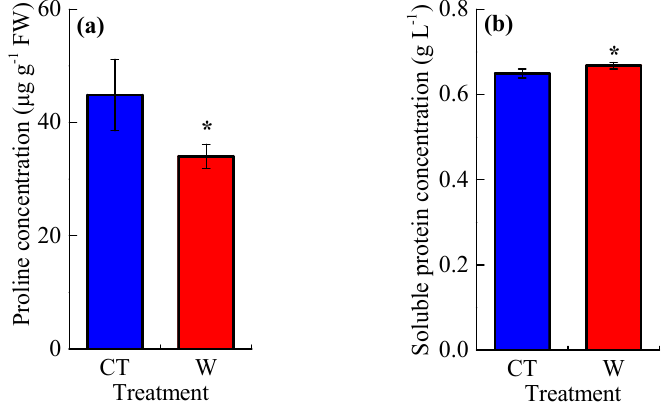
Figure 3. The concentrations of ( a ) proline and ( b ) soluble protein in Cunninghamia lanceolata under the control (CT) and warming (W) treatments (mean ± standard deviation, n = 5 replicates each). *, Indicates significant ( p < 0.05) di ff erences between the control and warming